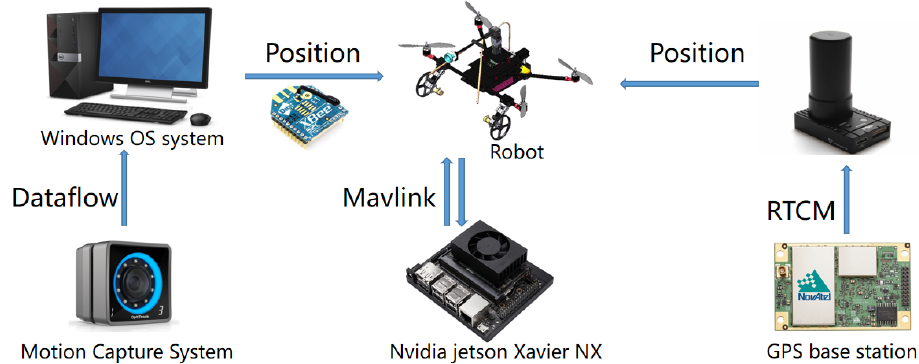
Figure 15. Setup of the robot in the experiments.